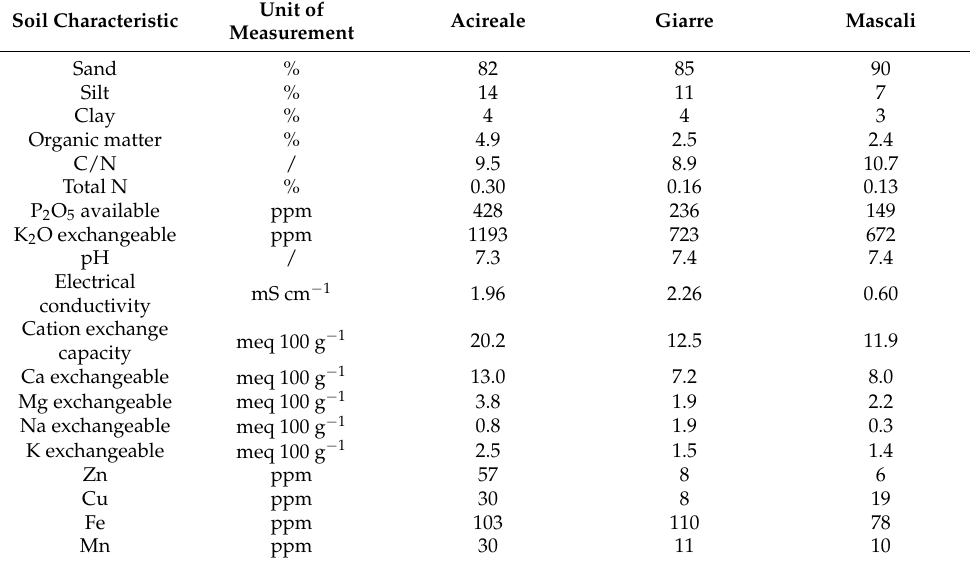
Table 1. Description of soil characteristics ( − 30 cm depth) of the three locations under